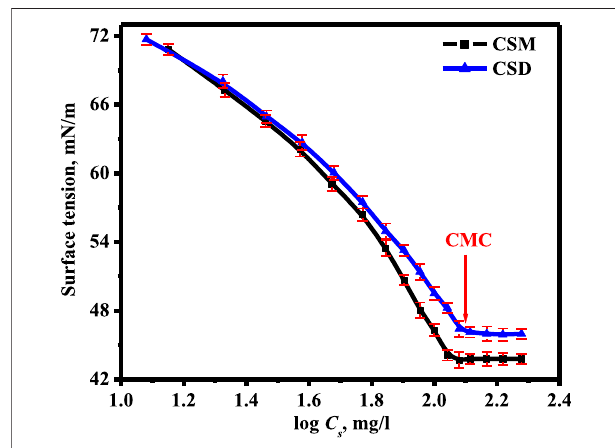
FIGURE1| Variationofsurfacetension( γ )vs.surfactantconcentrationin 3.5% NaCl solution.